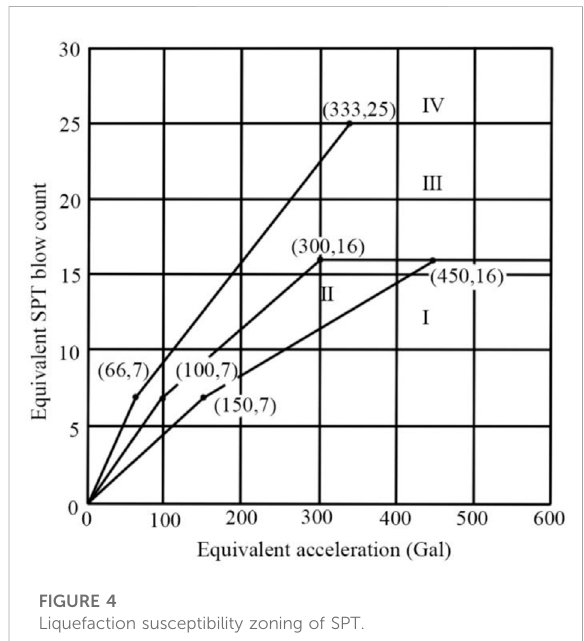
FIGURE 4 Liquefaction susceptibility zoning of